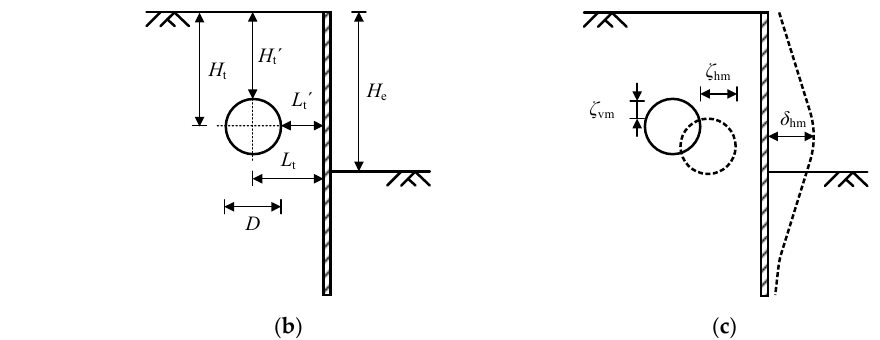
Figure 1. Dimensions, relative positions and structural deformations of the deep excavation and tunnel: ( a ) Plane diagram; ( b ) Cross section diagram; ( c ) Deformation diagram.